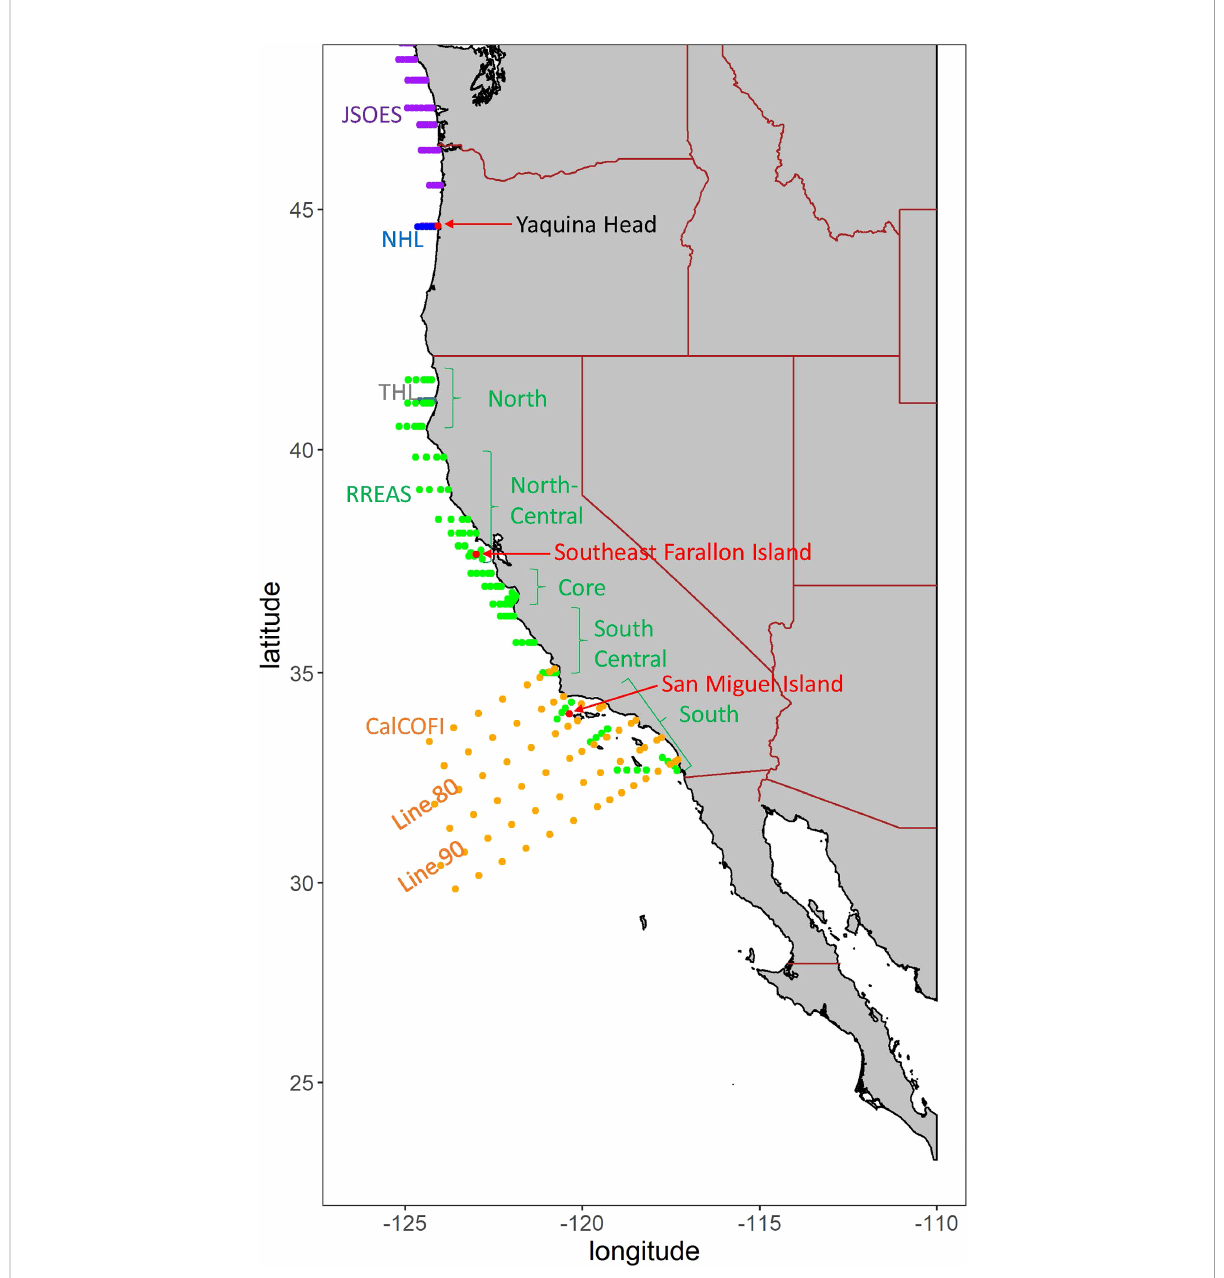
FIGURE 1 Locations of the surveys. Land-based locations are in red. The Juvenile Salmon and Ocean Ecosystem Surveys (JSOES) is in purple, the Newport Hydrographic Line (NHL) in blue, the Trinidad Head Line (THL) in gray, the Rock fi sh Recruitment and Ecosystem Assessment Survey (RREAS) in green, and the California Cooperative Oceanic Fisheries Investigation (CalCOFI) in